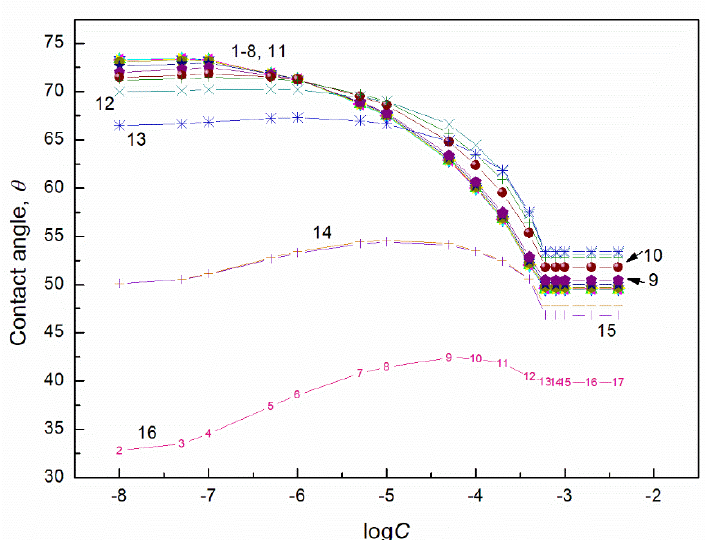
Figure 5. A plot of the contact angle ( 𝜃 ) of aqueous solution of TX165 + RL mixtures on the PMMA surface vs. the logarithm of the TX165 concentration ( 𝐶 ). Curves 1 – 16 correspond to the constant RL concentration equal to 0.0002, 0.0005, 0.00125, 0.003, 0.00625, 0.01, 0.02, 0.05, 0.1, 0.5, 1, 5, 10, 20, 30 and 40 mg/dm 3 , respectively.